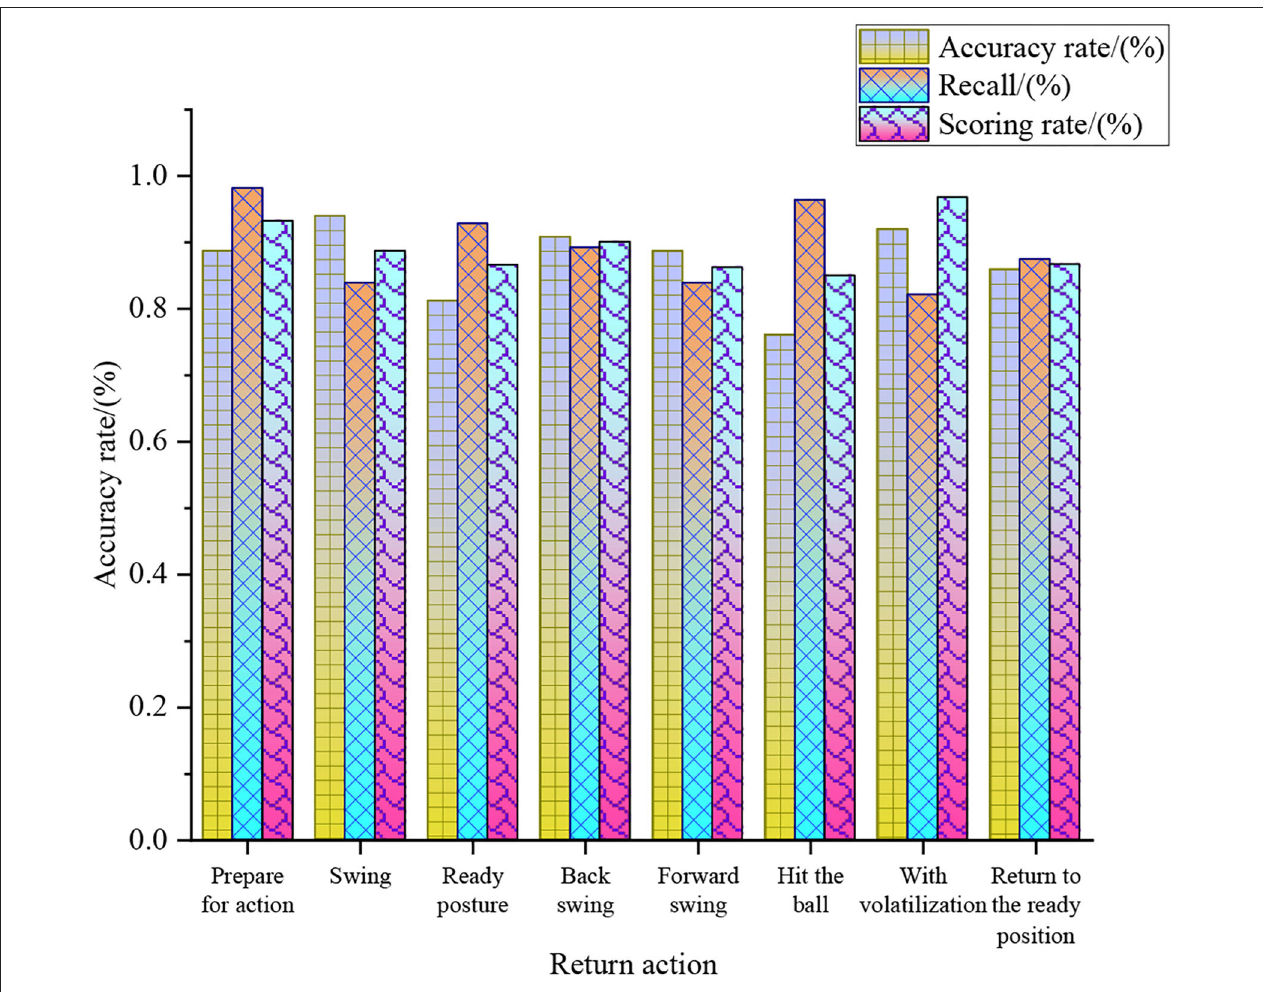
FIGURE 10 | Analysis of different return strategies of the tennis sports